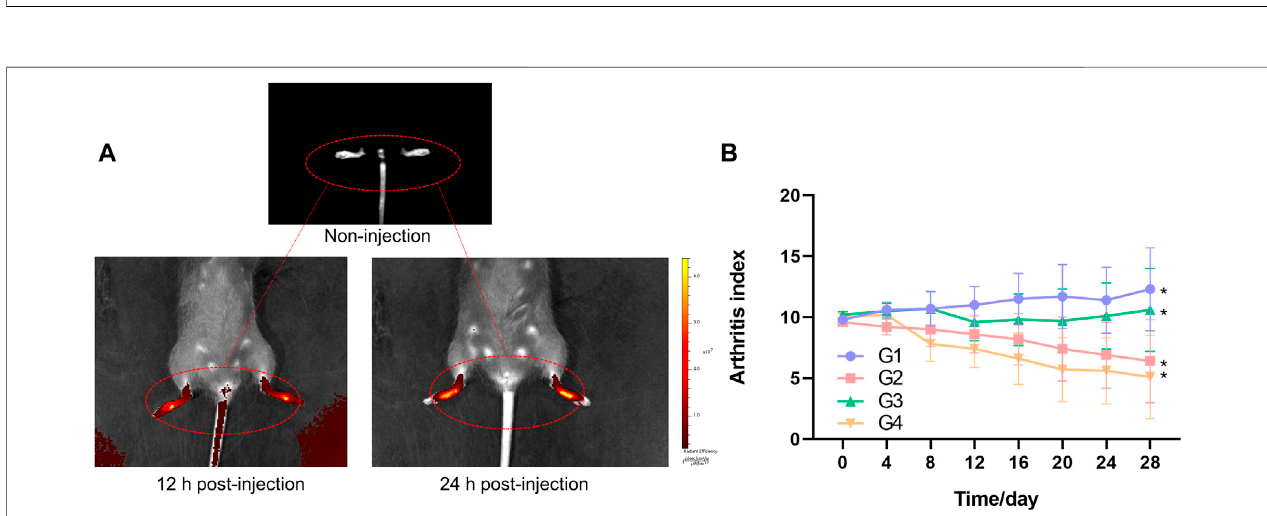
FIGURE 7 | (A) Fluorescence images of in fl amed paws of CIA mice of non-injection, 12 h post-injection, and 24 h post-injection of TP-PLGA-Au@RGD-Cy7/HA hydrogels, and mice were intraarticularly administered. (B) Arthritis index versus time for CIA mice. Arthritis indices were signi fi cantly different among groups (* p < 0.05).